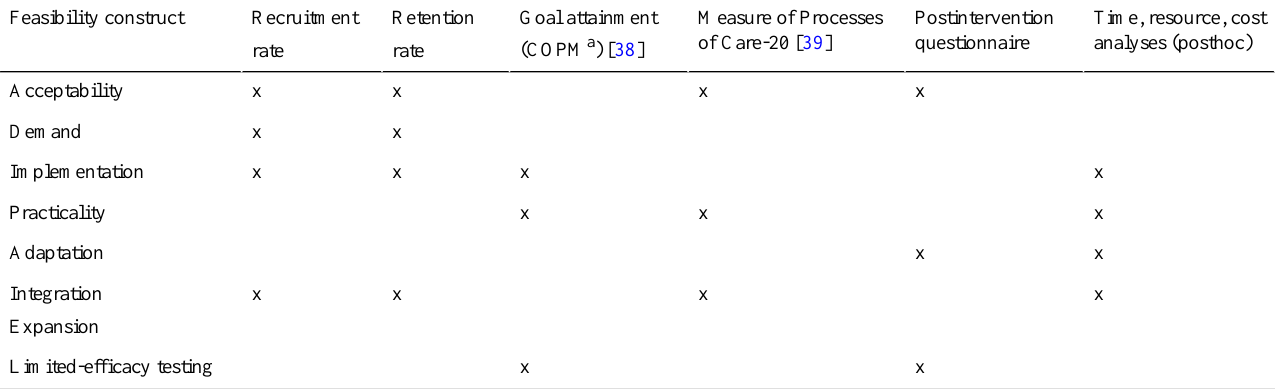
Table 1. Primary feasibility outcome measures.